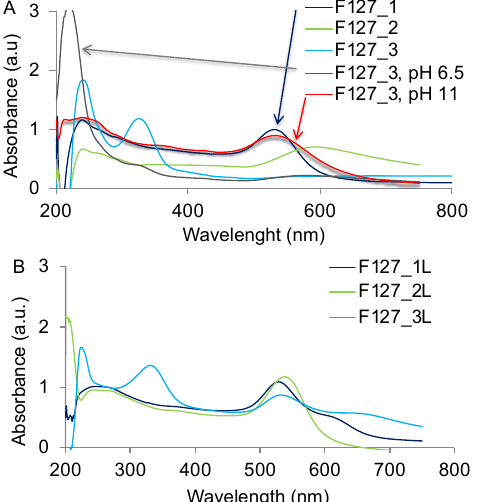
Figure 8. Absorbance spectra in the mixtures of 0.25 mM HAuCl 4 and different F127 batches ( A ) before and ( B ) after lyophilization. The HAuCl 4 concentration was 0.25 mM and F127 concentration was 6.3%. The reaction mixtures were incubated for 2 h (unless shown 1 h) at 45 °C.